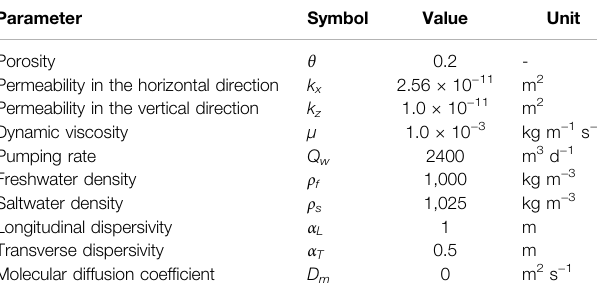
TABLE 1 | Values of parameters in the homogeneous